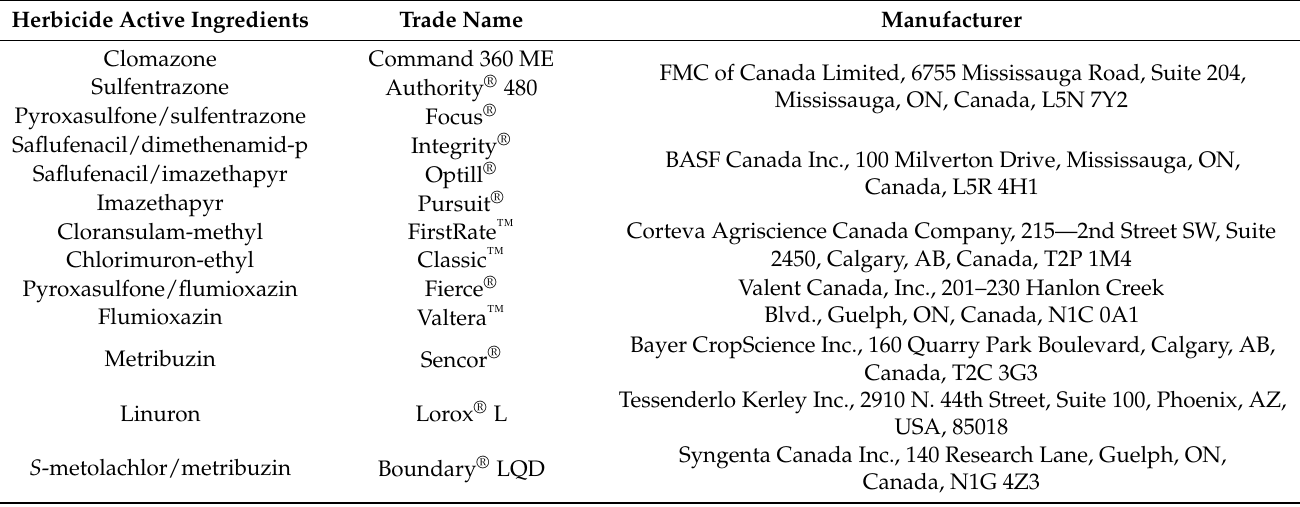
The herbicide treatments were applied using a CO 2 -pressurized backpack sprayer equipped with a hand-held boom containing four ULD-120-02 (Pentair Canada Inc.,